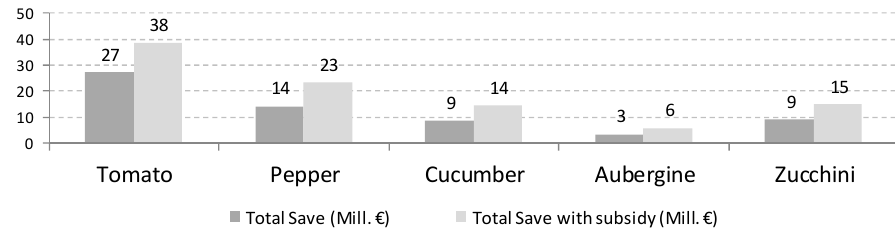
Figure 11. Savings (million €) in horticultural sector in southeast Spain using PV systems.